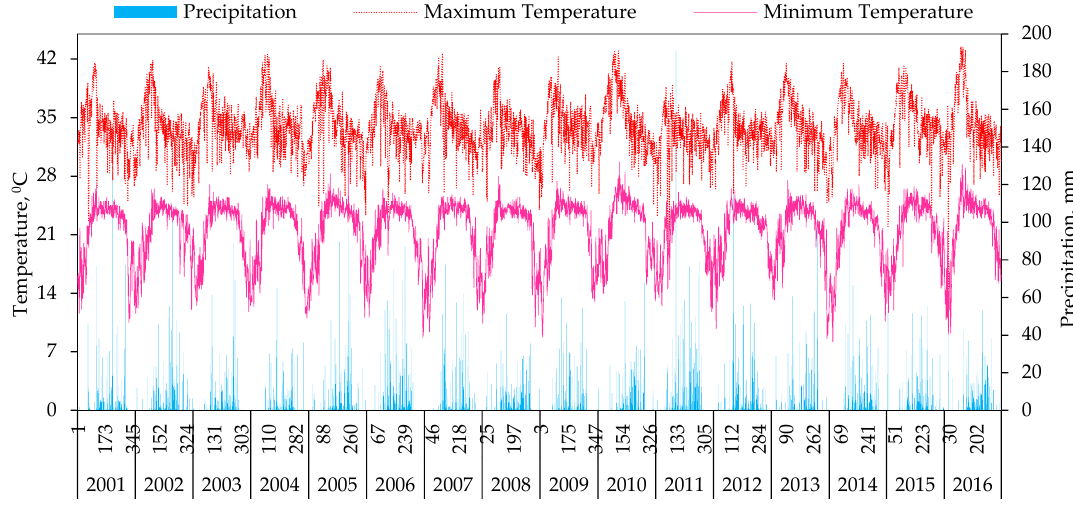
Figure 4. Daily temperature and precipitation records at Lampang station during 2001 – 2016.